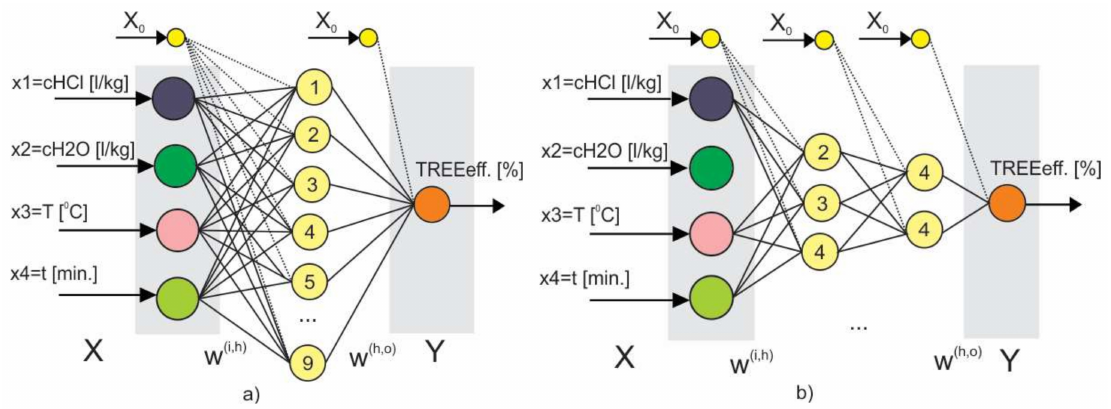
Figure 10. ANN topology for TREE modeling: ( a ) ANN-4/10/1; and, ( b ) ANN-4/3/2/1.